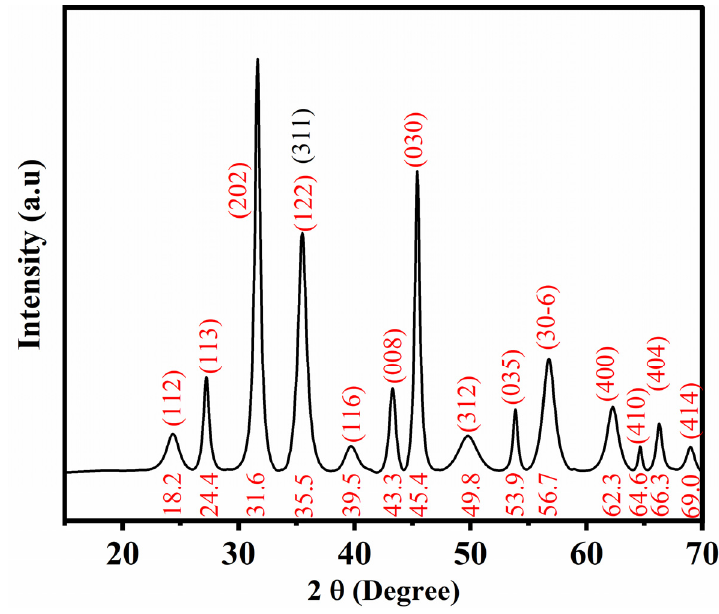
Figure 1. XRD spectra (JCPDS standard) of the green synthesized Fe x O y -NPs using aqueous extract of Phoenix Dactylifera L.